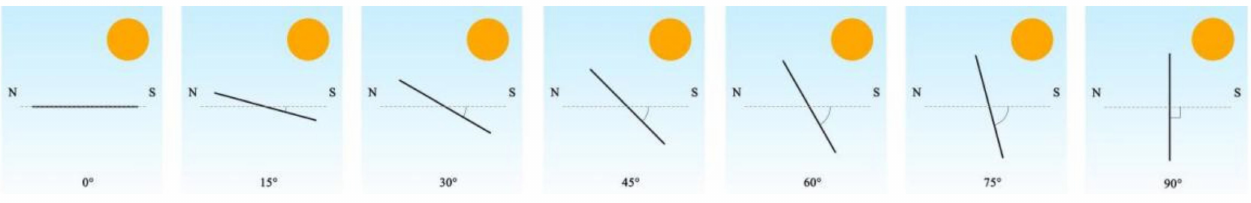
Figure 16. Louver inclination